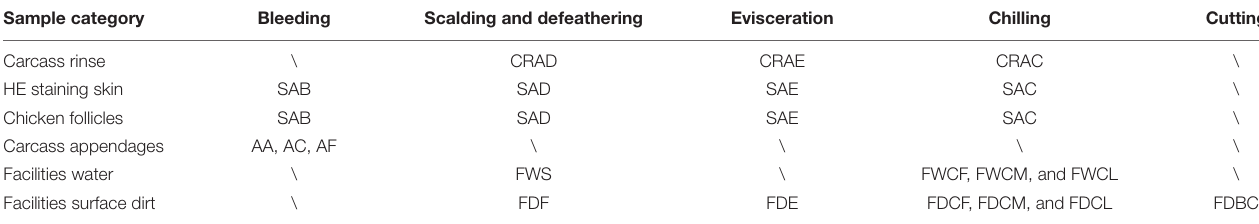
TABLE 1 | The sampling scheme for bacterial contamination of chicken skin follicles during slaughter. Sample